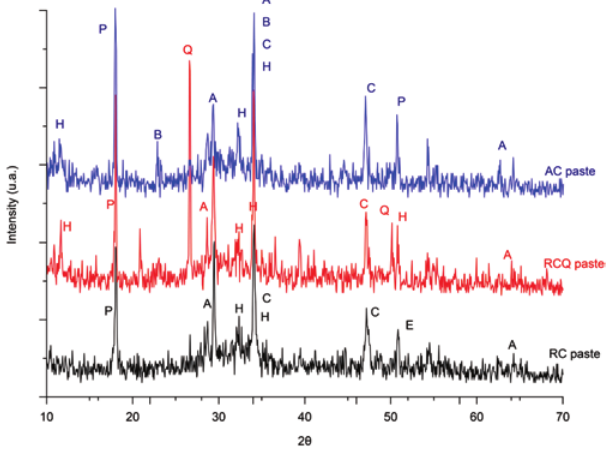
Diffractograms of pastes produced with anhydrous Portland cement (AC), recycled cement (RC), and 15% replacement of cement recycled by sand